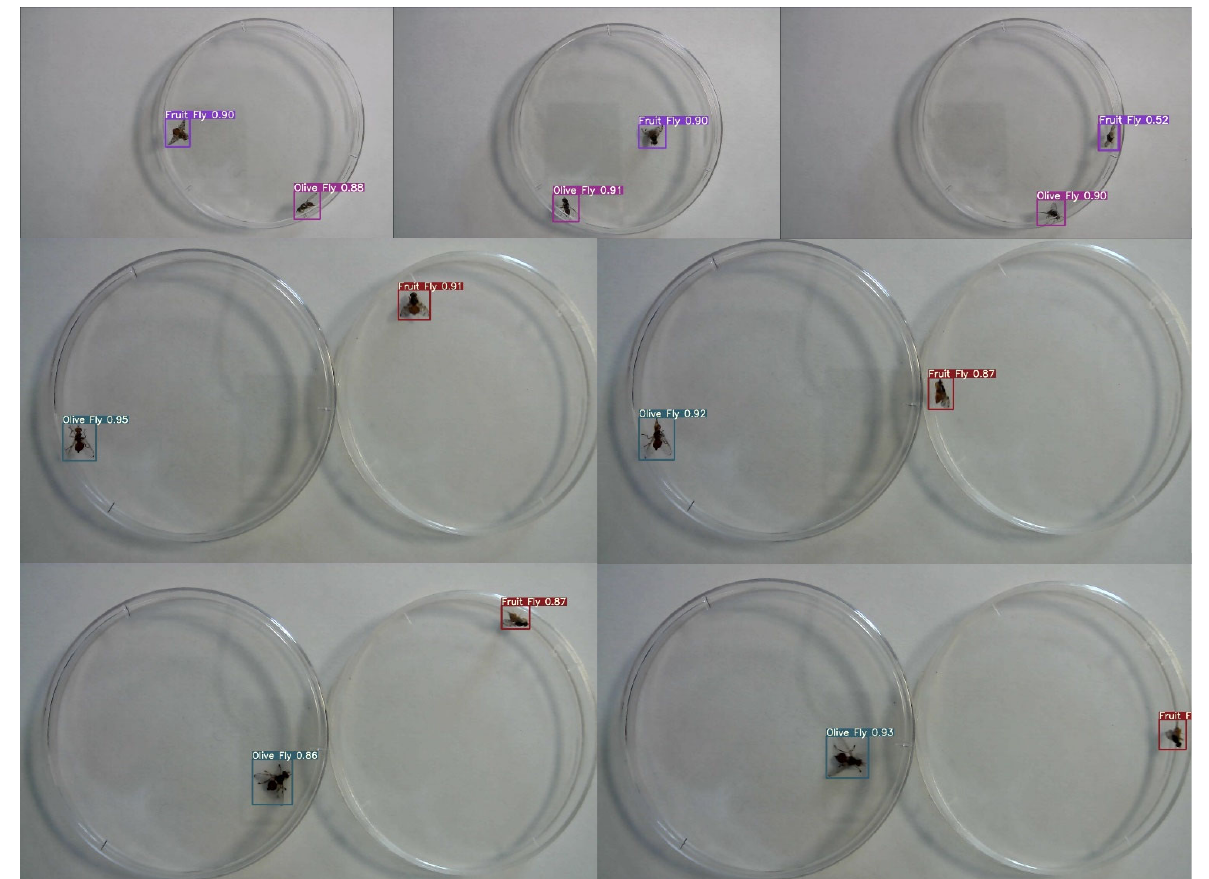
Figure 8. YOLO testing results using performance set. Colored boxed indicated the olive fruit fly (i.e., pink and green) and the Mediterranean fruit fly (i.e., purple and red) recognized from the network along with the precision rate percentage.